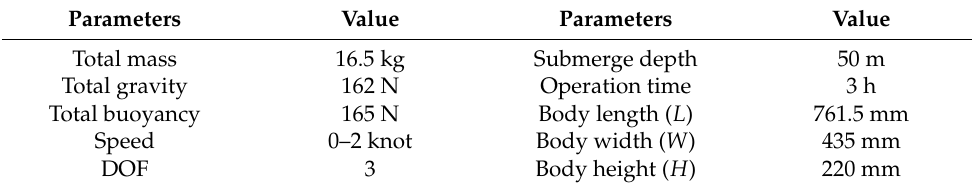
Figure 1. ( a ) Mechanical structure introduction of the underactuated underwater vehicle. ( b ) Refer- ence frames of the underactuated underwater vehicle. ( O E - XYZ ) represents the earth-fixed reference frame, ( o b - xyz ) is the body-fixed reference frame. Red color indicates the actuated degrees of freedom (surge, heave, and yaw). Table 1. Basic parameters of the underactuated underwater